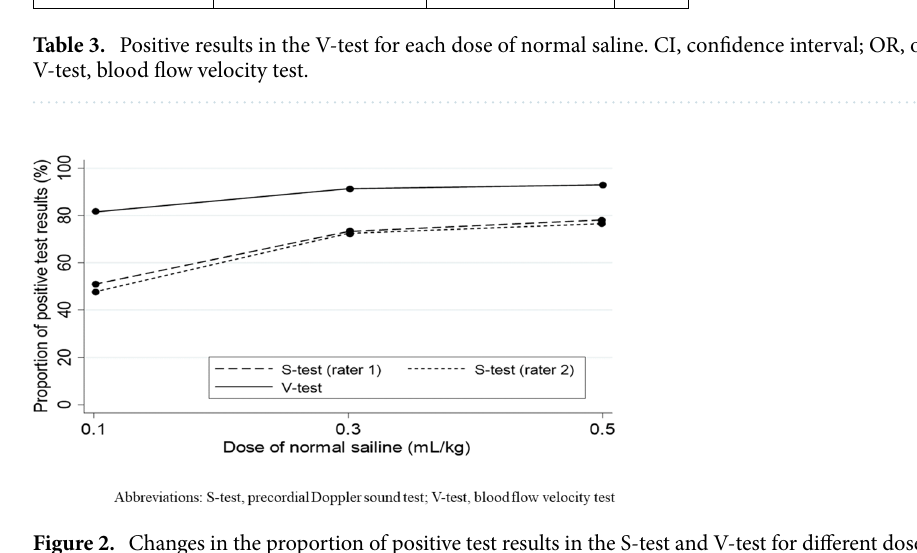
Figure 2. Changes in the proportion of positive test results in the S-test and V-test for different doses of normal saline. The proportions of positive test results were significantly higher in the V-test than in the S-test across all doses of normal saline. S-test, precordial Doppler sound test; V-test, blood flow velocity